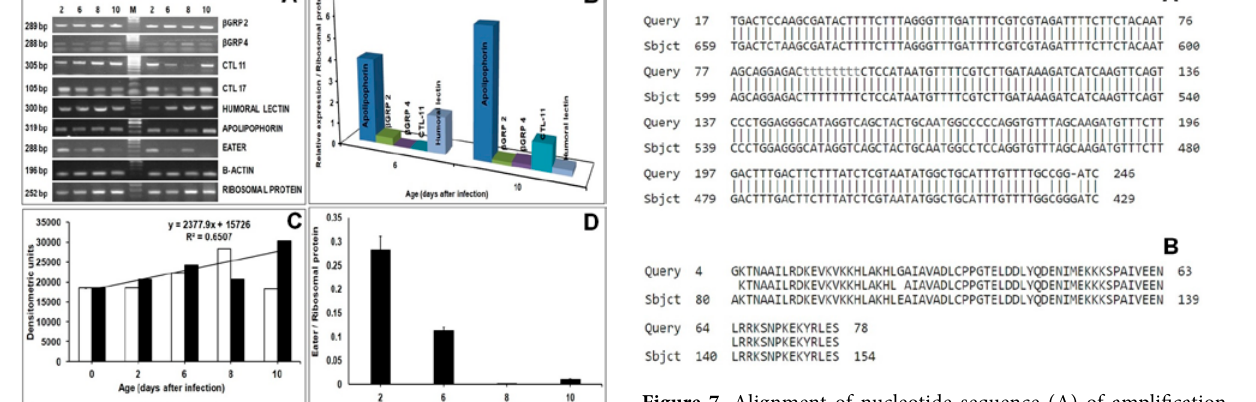
Figure 7. Alignment of nucleotide sequence (A) of amplification product from heterologous expression profile of Eater gene of Dros- ophila (query) with nucleotide sequence (subject) of the most simi- lar gene, B. mori uncharacterized transcript variant X2 (Accession No. XM_004928120.3) revealed by NCBI-BLASTn analysis, showed 98 % similarity. (B) Protein sequence of the uncharacterized tran- script variant (subject) is aligned with translated sequence of the Eater like gene (query) showing 97%